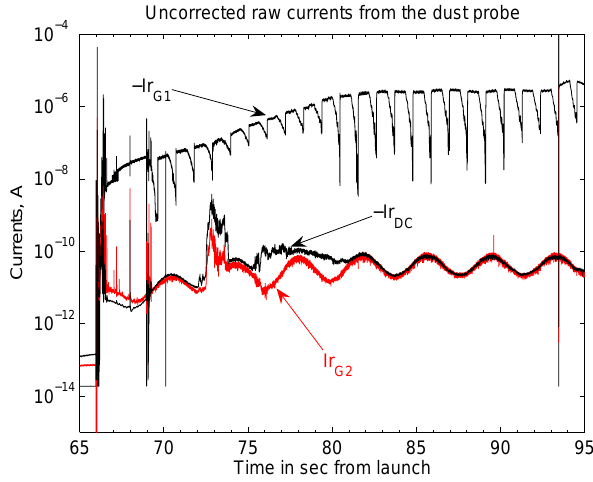
Fig. 2. The raw currents to G1, G2 and the bottom plate. The cur- rents are shown as positive but both Ir G1 and Ir DC were measured as negative currents while Ir G2 is